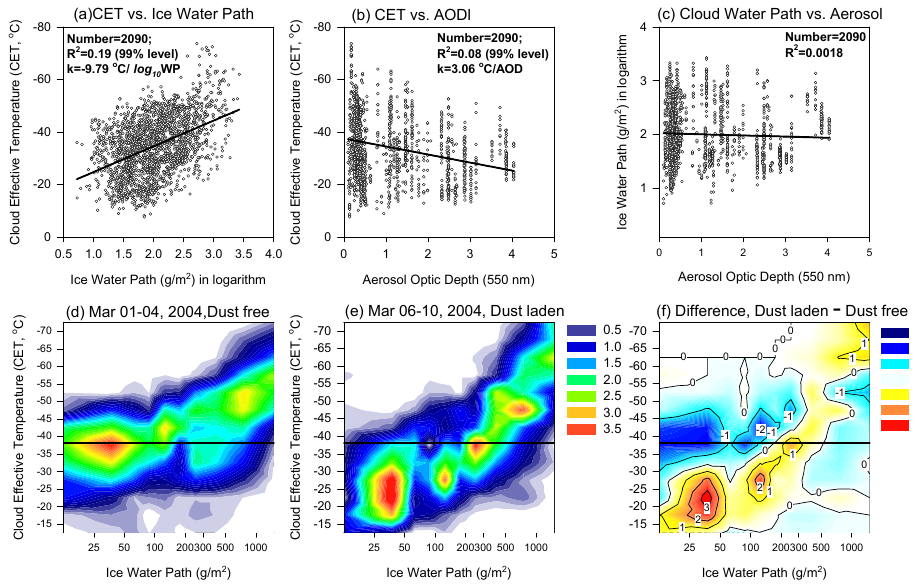
(c) Cloud Water Path vs. Aerosol